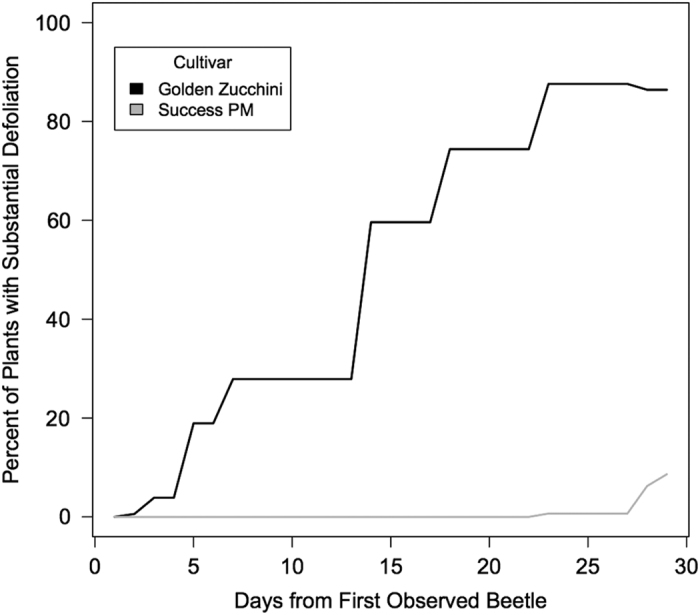
Leaf defoliation progress in field no-choice plots. Averaged number of plants with substantial (⩾10% leaf defoliation) in no-choice field plots. Difference between cultivars in leaf damage was significant (P<0.0001) at day 2, and continued to be at the final day of observation, day 29 (P<0.0001). A. vittatum were added to ‘Success PM’ plots on day 18, about 4 days before reflected by an increase in defoliated ‘Success PM’.